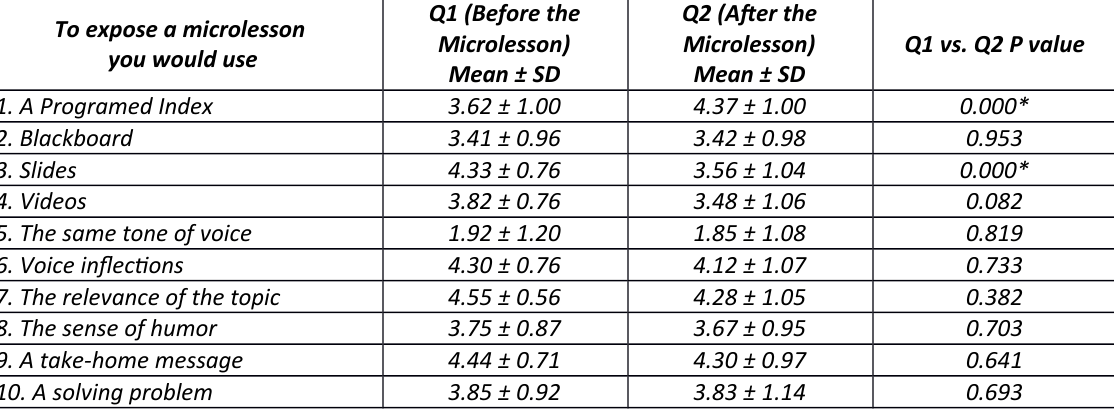
Table 2. Results obtained with the second questionnaire before the microlesson session (Q1) and after the microlesson session (Q2) and statistical comparison of both results. The results are shown as means±standard deviations, and the statistical comparison is shown as p values for the Mann-Whitney test.